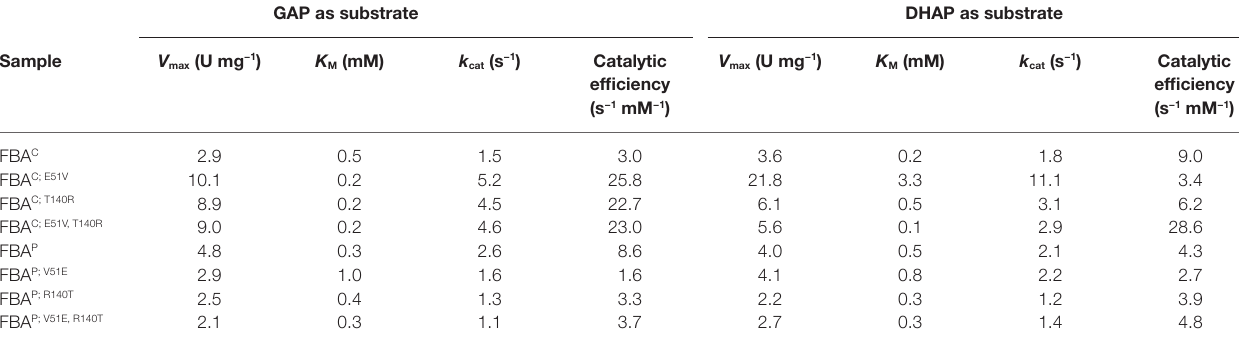
TABLE 2 | Kinetic Parameters (FBP synthesis) of native FBAs and SDMs in gluconeogenesis.